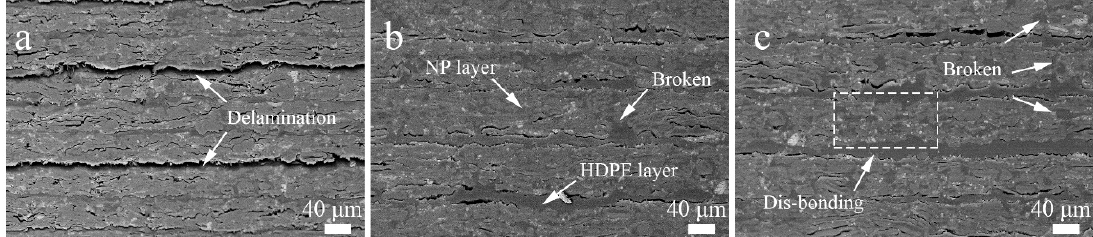
Figure 2. BSEM images of ( a ) unmodified composite; ( b ) 0.05M SA modified composite and ( c ) 0.15M SA modified composite.